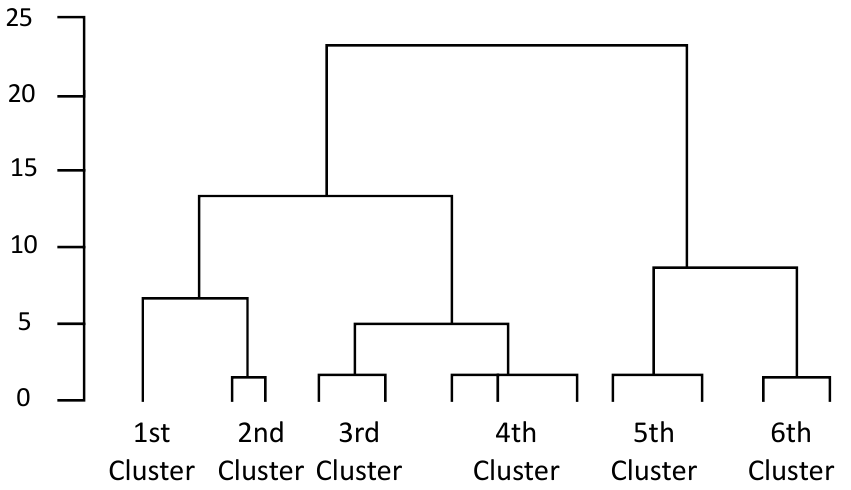
Figure 1. Cluster Figure 1. Cluster dendrogram.